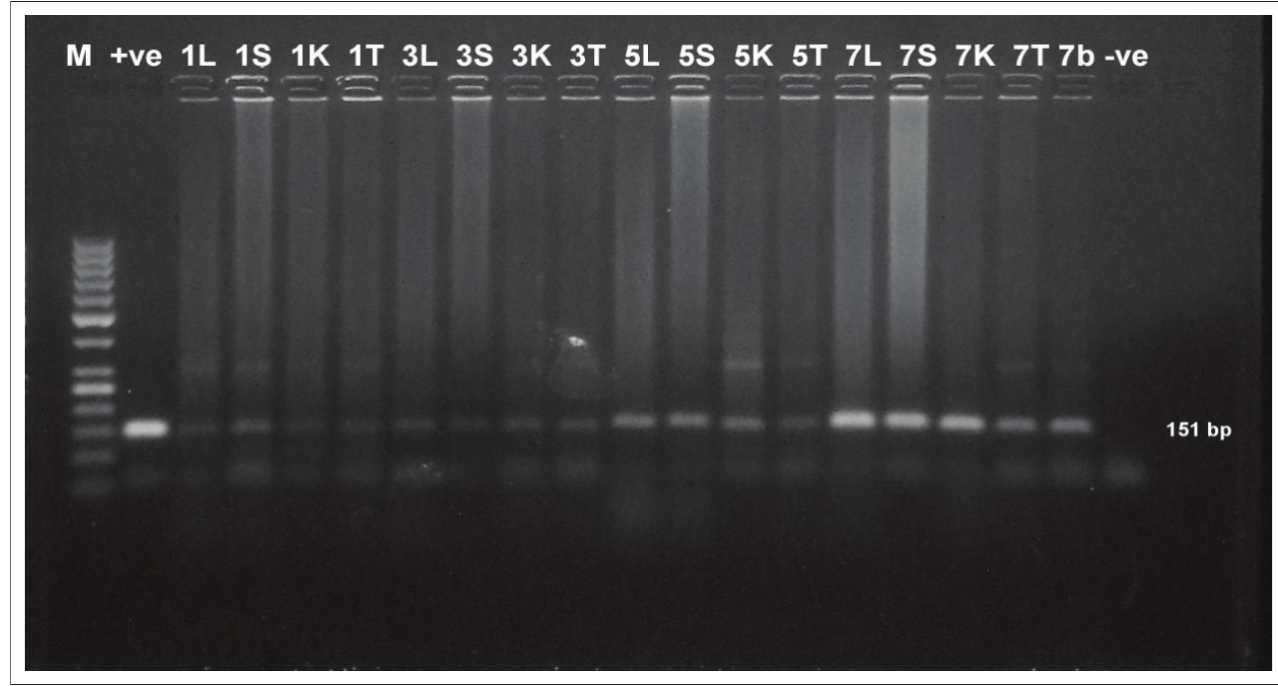
FIG URE 5: Polymerase chain reaction R amplification of Deoxyribonucleic acid extracted from tissues of infected male mice (parasitaemic stage) using Trypanosoma brucei primer set. M: 50 base pairs molecular weight Deoxyribonucleic acid marker, +ve: positive control, -ve: negative control, 1, 3, 5, 7: days post infection and L (liver, ) S (spleen), K (kidneys), T (testes) and B (brain).